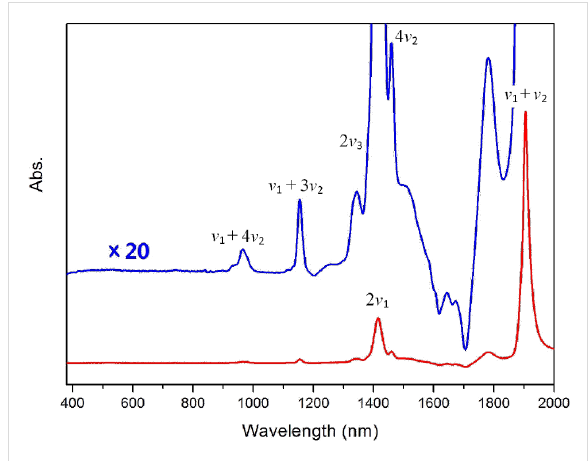
Figure 2: The UV–vis-NIR spectra of water in [BMIM] + [BF 4 ] − with dry [BMIM] + [BF 4 ] − used as reference. The blue spectrum is a 20-times magnification of the red original spectrum in order to enlarge the weak